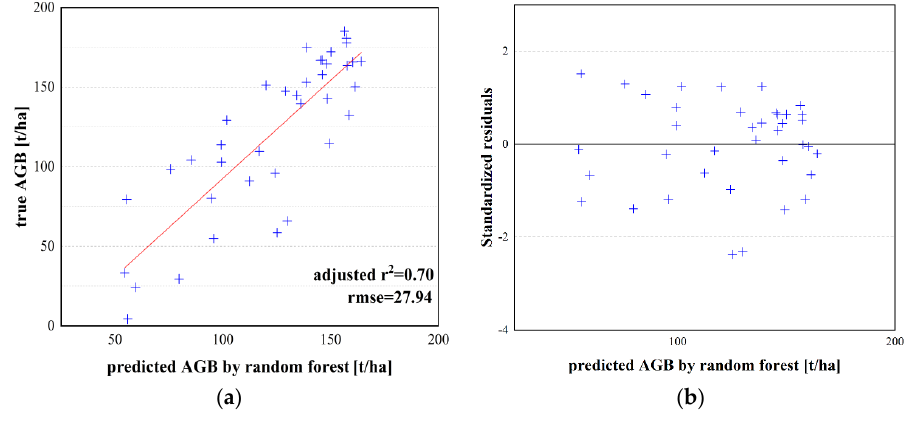
Figure 9. ( a ) Random forest model; ( b ) residual analysis graph.